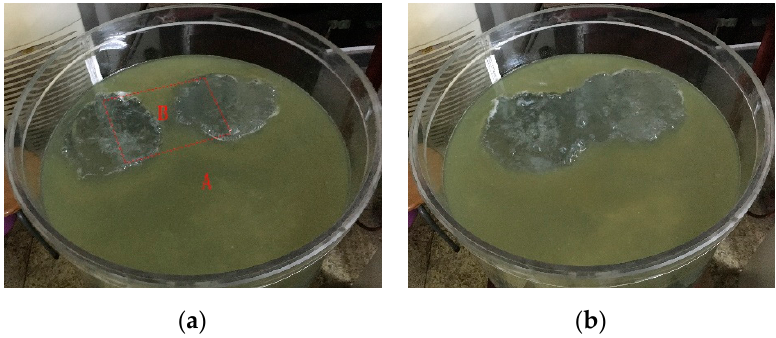
Figure 8. The slag eyes in the water model with double porous plugs (16 mm OLT): ( a ) Q = 0.286 m 3 /h, ( b ) Q = 0.381 m 3 /h.